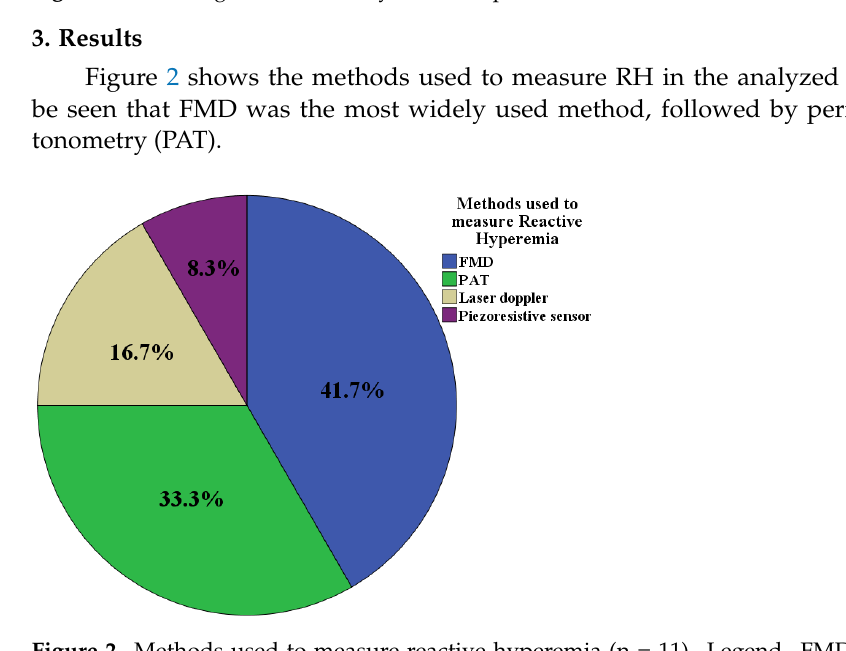
Figure 3. Methods used to assess the autonomic nervous system (n = 11). Legend. HRV: heart rate variability. CARTs: cardiovascular autonomic reflex tests. Microneurography of muscular sympa- thetic nerves. PET imaging: positron emission tomography. Figure 4 shows the evaluation parameters for HRV used in the analyzed studies. Lin- ear methods (SDNN, the root mean square of the sum of the squared differences of all successive RR intervals, and the coefficient of variation) were the most widely used, fol- lowed by frequency methods.